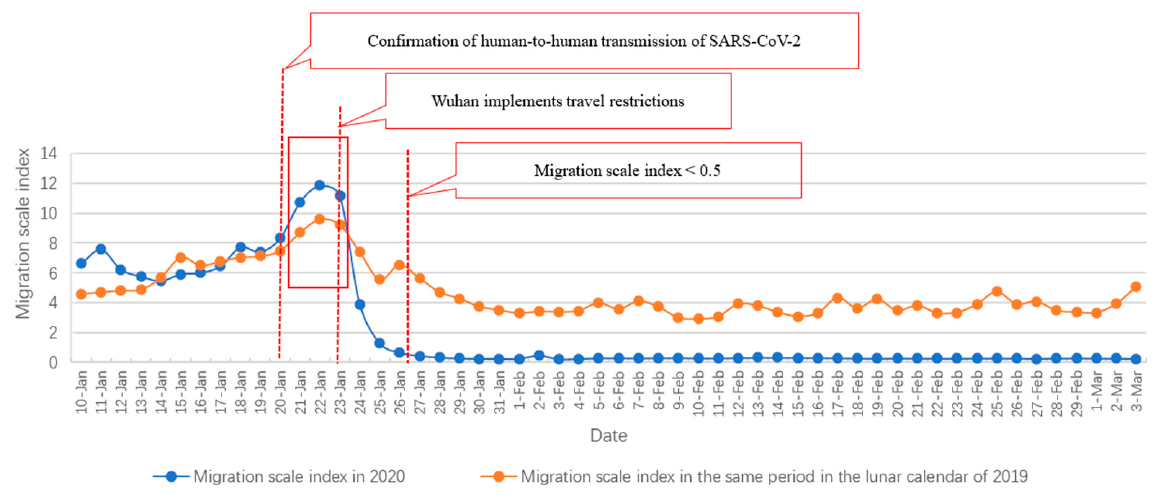
Figure 3. The trend of population migration from Wuhan during the Spring Festival in 2019 and 2020.